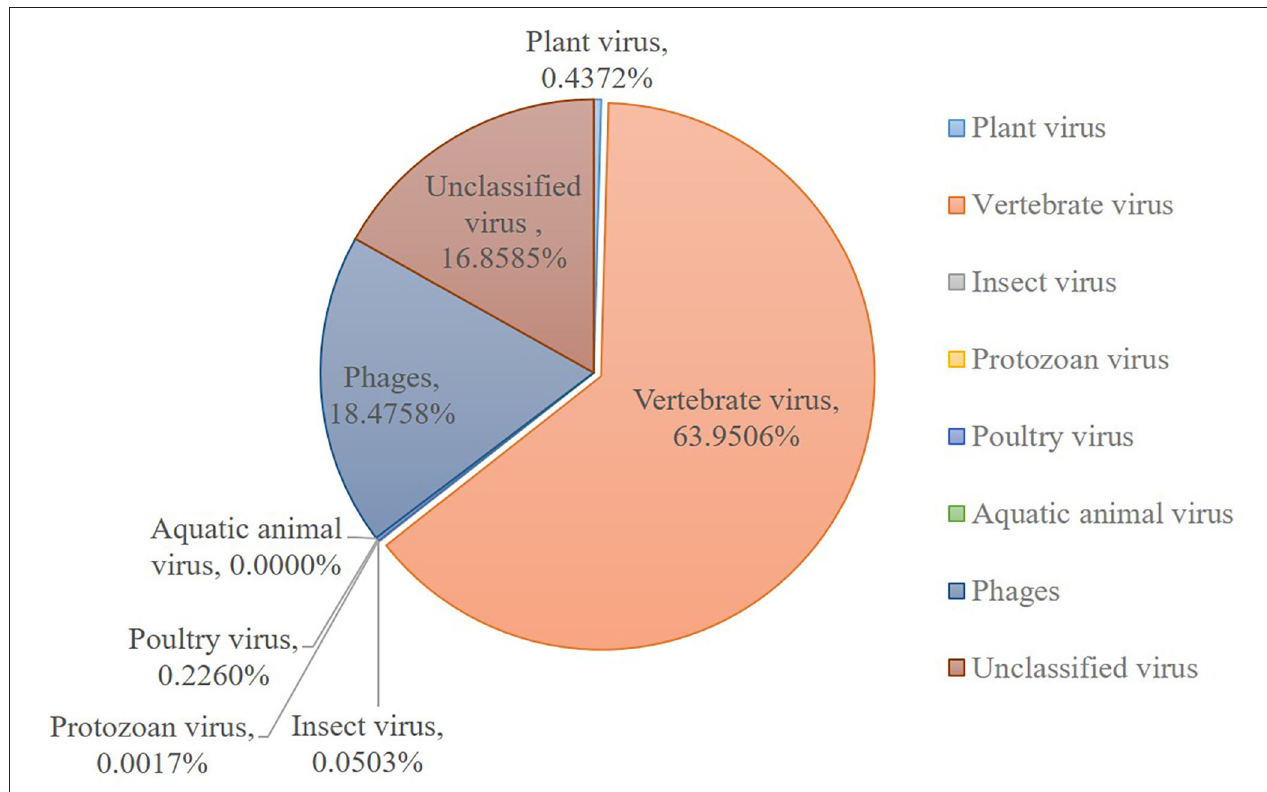
FIGURE 2 | Host wise distribution of eukaryotic viruses cataloged in the dog gut virome. Summary of the sequence classification at different taxonomic ranks by their assigned homology results of host information.